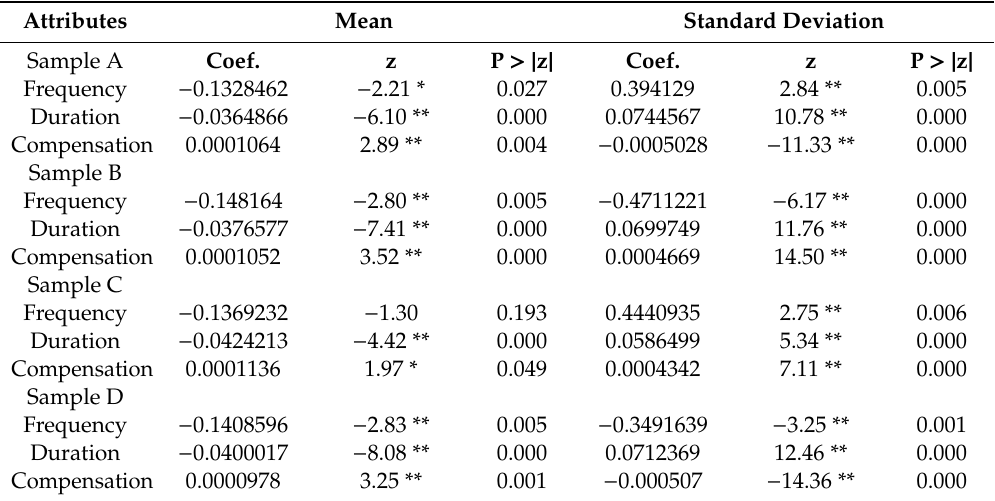
Table 5. Mixed logit model